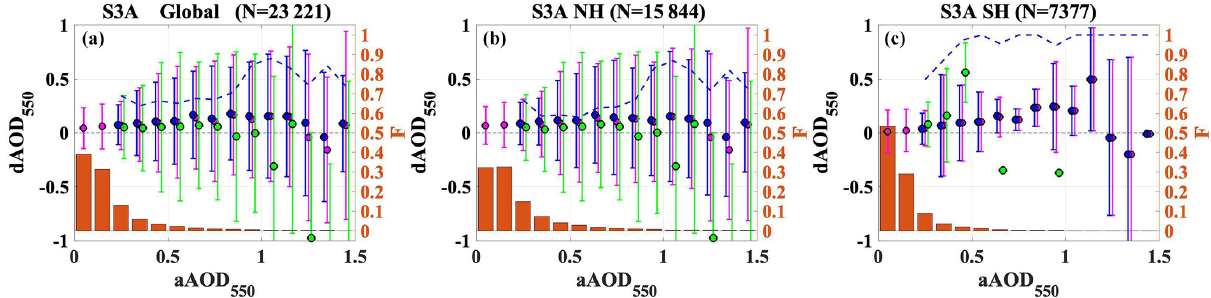
Figure 4. Global difference (a) as well as the NH (b) and SH (c) difference (dAOD 550 ) between syAOD and aAOD for aAOD binned in 0.2 intervals: median bias (circles) and bias standard deviation (error bars) for all and background (aAOD ≤ 0.2) AOD types (purple), as well as aerosol fine-dominated AOD (blue) and coarse-dominated AOD (green). The fraction ( F ) of points in each bin from the total number of matchups is represented by orange bars. The fraction of fine-dominated matchups in each bin is shown as the blue dashed